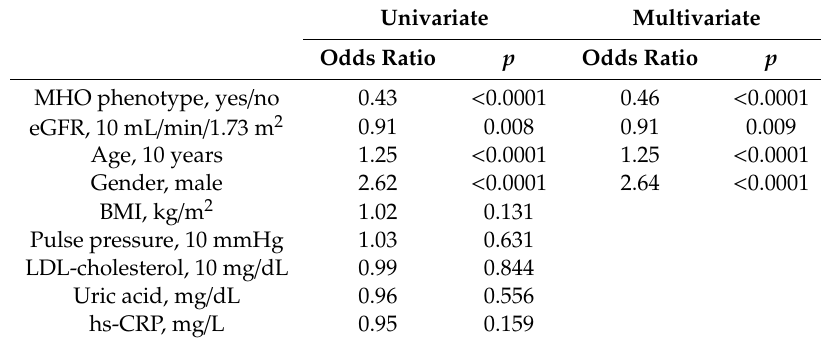
Table 4. Univariate and multivariate stepwise logistic regression analysis with left ventricular hypertrophy as dependent variable, in whole study